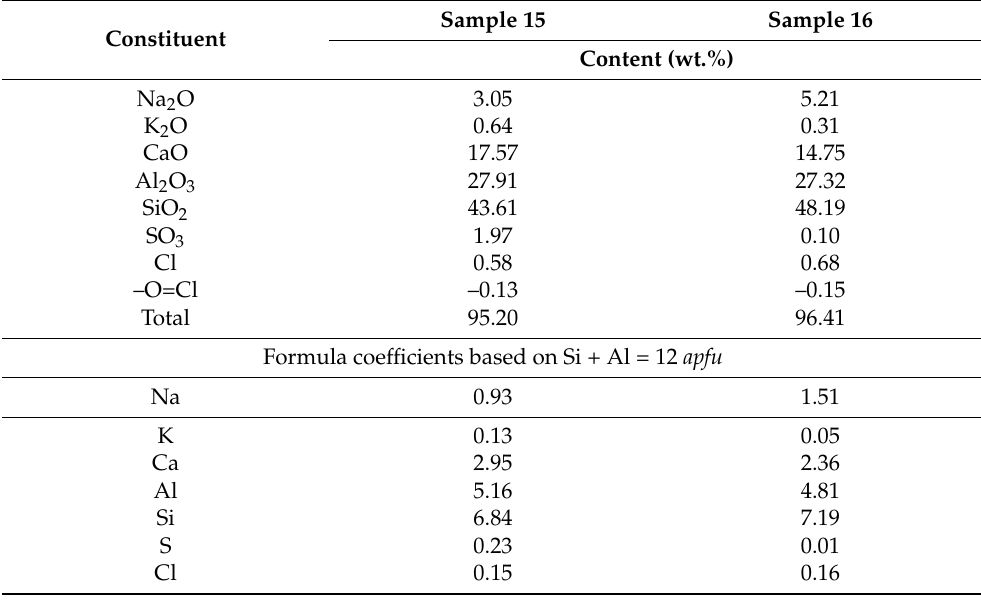
Table 3. Chemical composition (wt.%) of